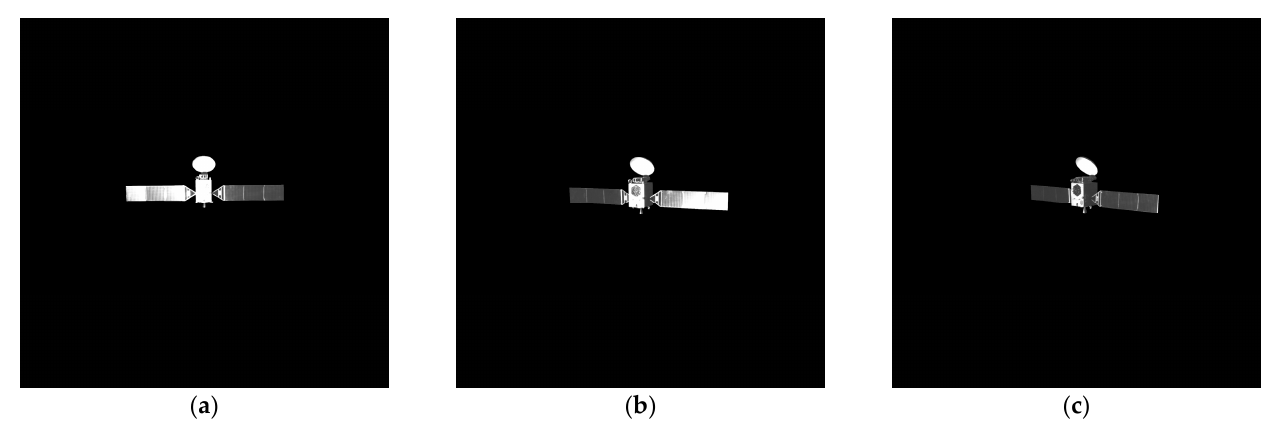
Figure 9. Image of the satellite model under different lighting conditions: ( a ) 0°; ( b ) 30°; ( c ) 60°. The specific shooting conditions are listed in Table 1. The target was photographed at different positions, attitudes, and lighting angles. Table 1. Image shooting conditions.